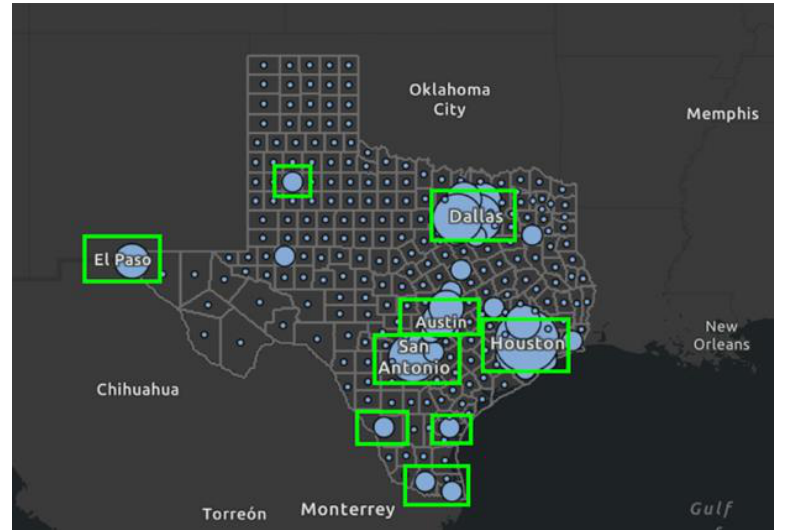
Figure 2. Texas counties included in the study are highlighted in green (dashboard developed by the Texas Department of State Health Services